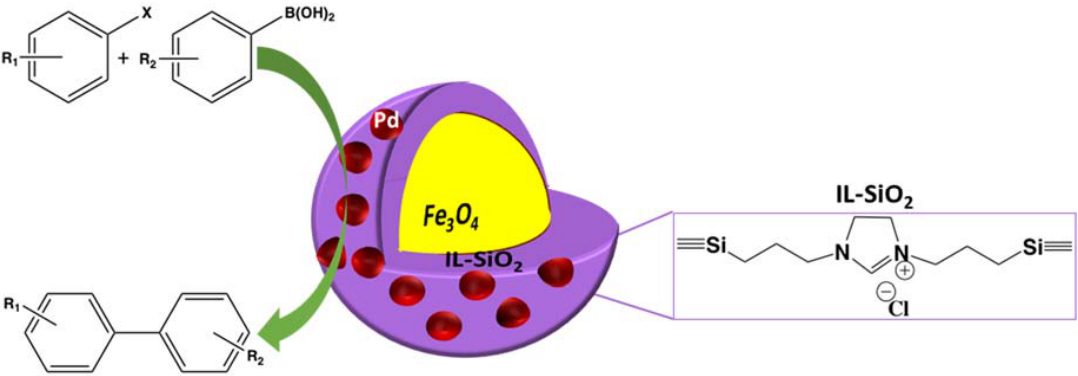
Figure 16. Suzuki cross ‐ coupling reactions catalysed by the Pd/MNP@IL ‐ SiO 2 ( palladium nanoparticles on the organic ‐ silica nanoparticles) catalyst [90] (Adapted with permission from American Chemical